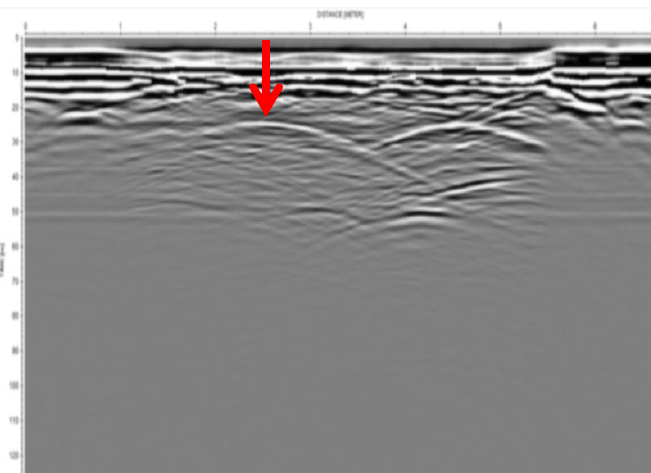
Figure 10 . Image of good pipe condition